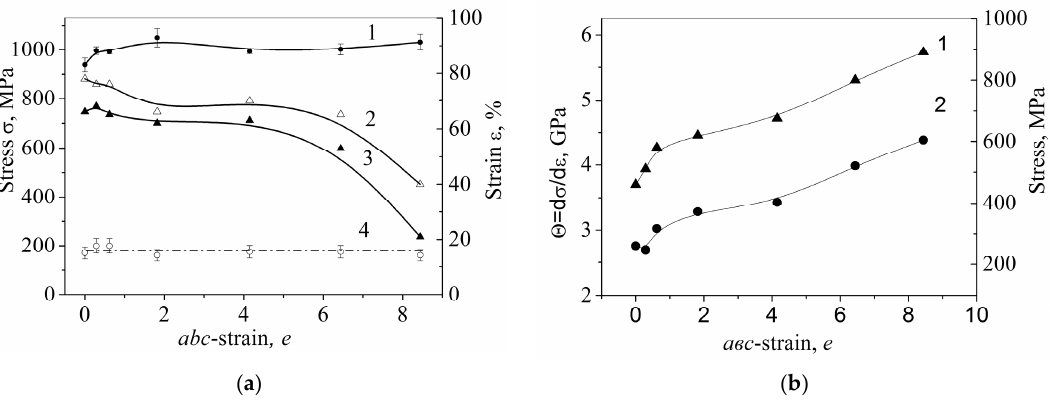
Figure 5. Mechanical characteristics of Ti 49.8 Ni 50.2 versus true strain after abc pressing: ( a ) 1 —ultimate tensile strength, 2 —elongation to fracture, 3 —uniform elongation, 4 —pseudo-yield stress; ( b ) 1 —yield stress σ y , 2 —strain hardening coefficient θ .